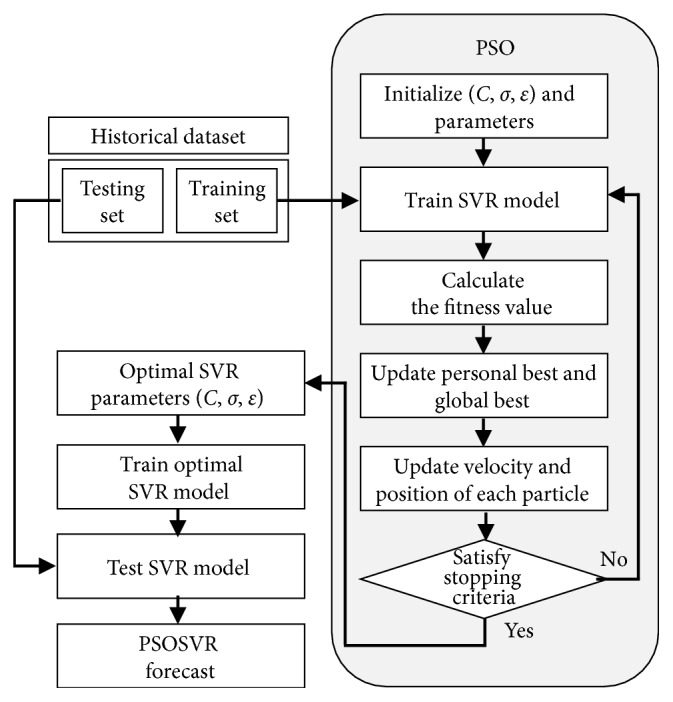
Flowchart of PSOSVR.